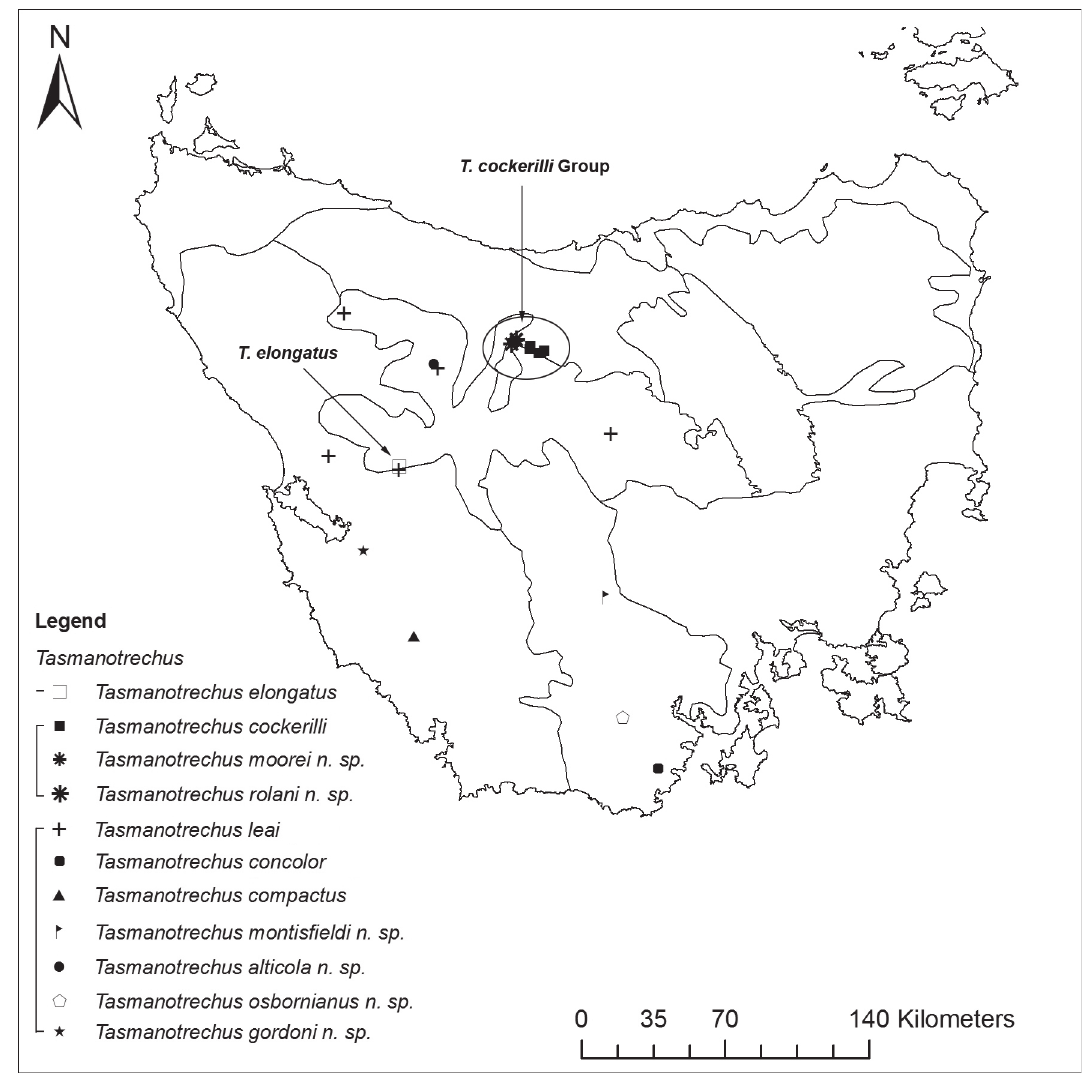
2. Head globose, lateral side of the pronotum posteriorly slightly sinuate ... G. rolani sp. nov. - Head elongate, lateral side of the pronotum posteriorly very sinuate ... G. florentinus sp. nov. Goedetrechus minutus sp. nov.